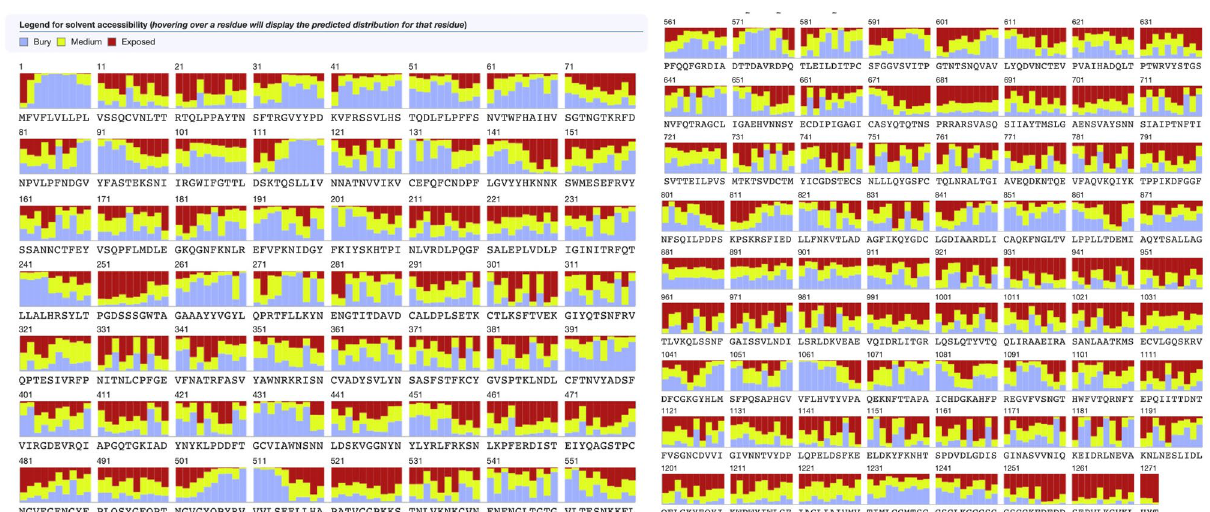
Figure 3. Surface accessibility of the SARS-CoV-2. The red color represents the exposed residues, the yellow color represents the medium exposed residues and the blue color represents the buried residues. In the SARS- CoV-2 spike protein, the B-cell epitopes in the 14 vaccine subunits are well-exposed according to the surface accessibility prediction, showing good potential that the B-cell receptor is able to interact with the virus to trigger the immune response.